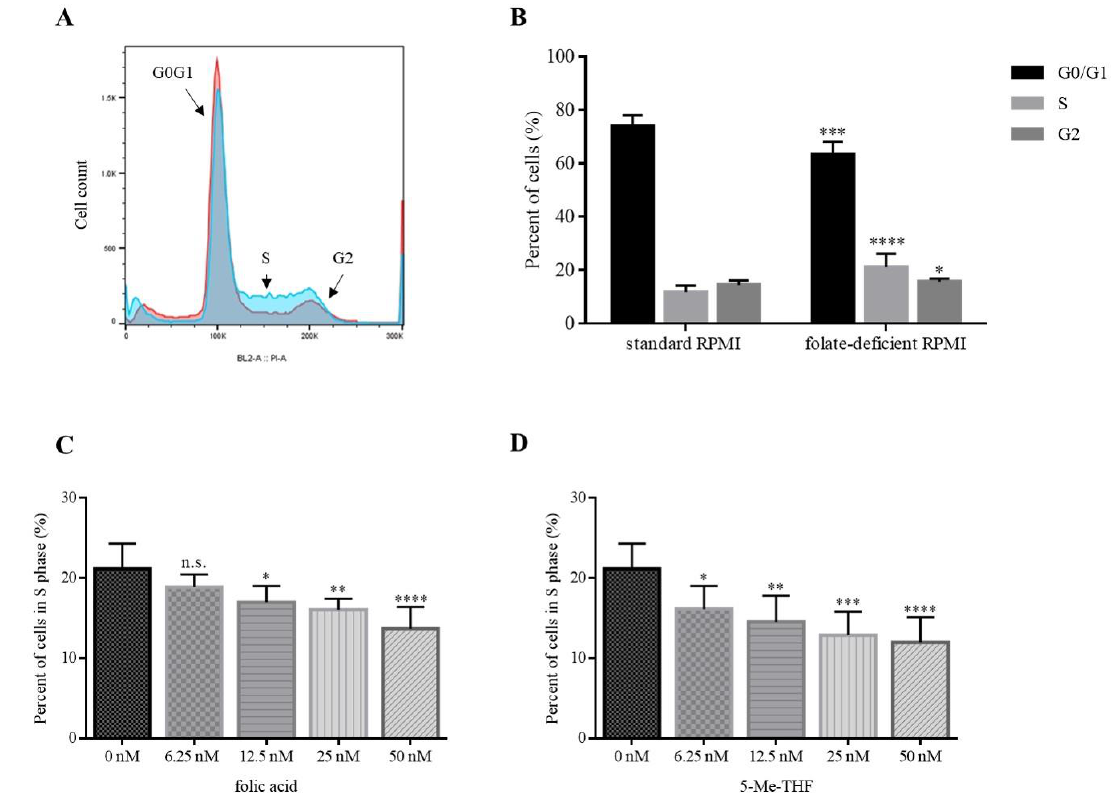
Figure 2. Folate deficiency causes a reversible arrest in the S-phase of the cell cycle. ( A ) Representative histogram of the cell cycle of LCL using alcohol fixation and propidium iodide DNA staining. LCLs were cultured for 10 days in standard RPMI medium (red curve) and in medium without FA (blue curve). ( B ) Graph represents the average proportion of cells in the G0 / G1, S, and G2 phase of cells cultured in standard RPMI medium and in folate-deficient medium ( n = 10). ( C , D ) Concentration-dependent reversal of the proportion of cells in the S-phase. LCLs were cultured in folate-deficient medium for one week and then cultured for 72 h in the presence of di ff erent concentrations (6.25 nM, 12.5 nM, 25 nM and 50 nM) of FA ( C ) or 5-Me-THF ( D ). In each experiment, 1 × 10 6 cells of each LCL were analysed. Values are means ± SD. Statistical di ff erences were determined by ANOVA with Tukey’s multiple comparison test. n.s. (not significant) p > 0.05, * p ≤ 0.05, ** p ≤ 0.01, *** p ≤ 0.001, **** p < 0.0001 compared to control ( n =